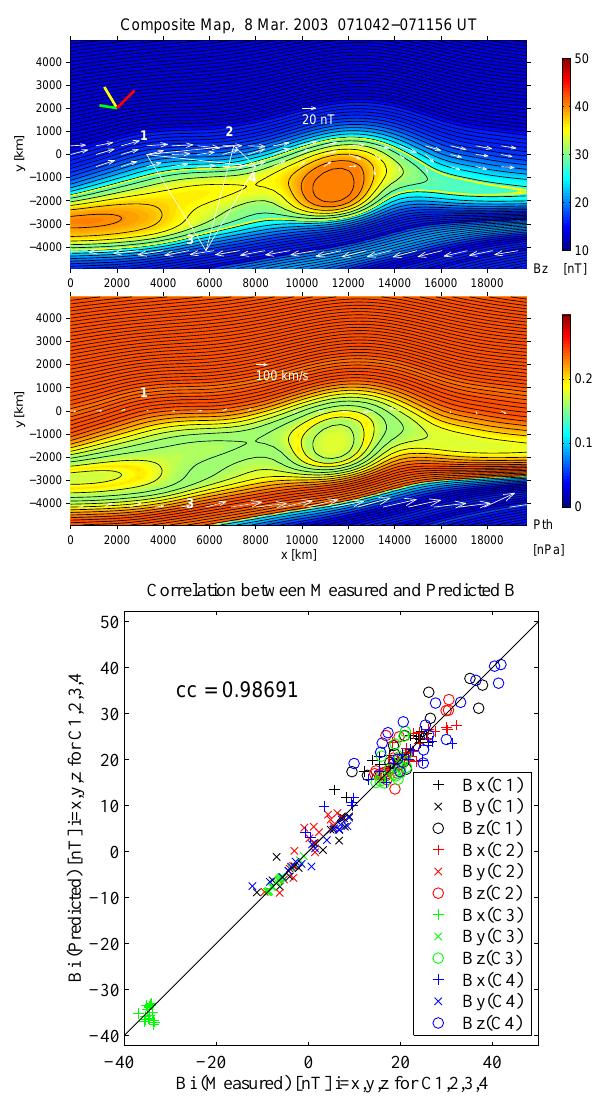
Fig. 5. Field and pressure maps and associated scatter plot for FTE